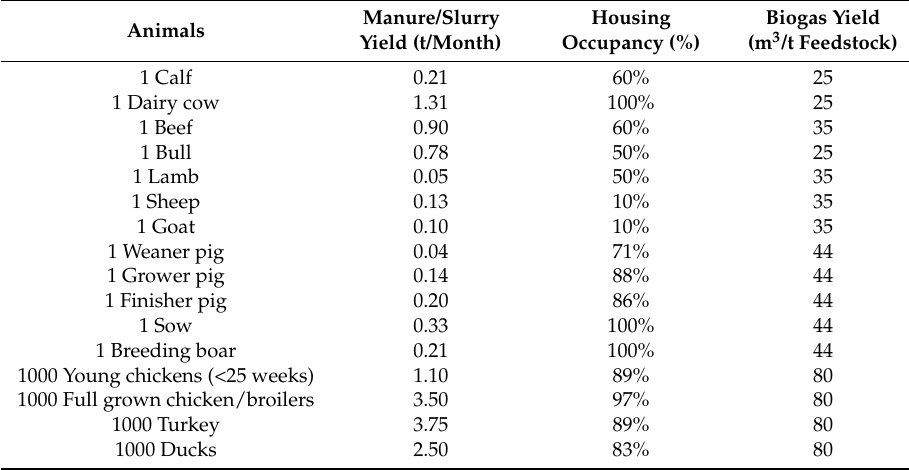
Table 1. AD feedstock characteristics from animal manure/slurry [27].